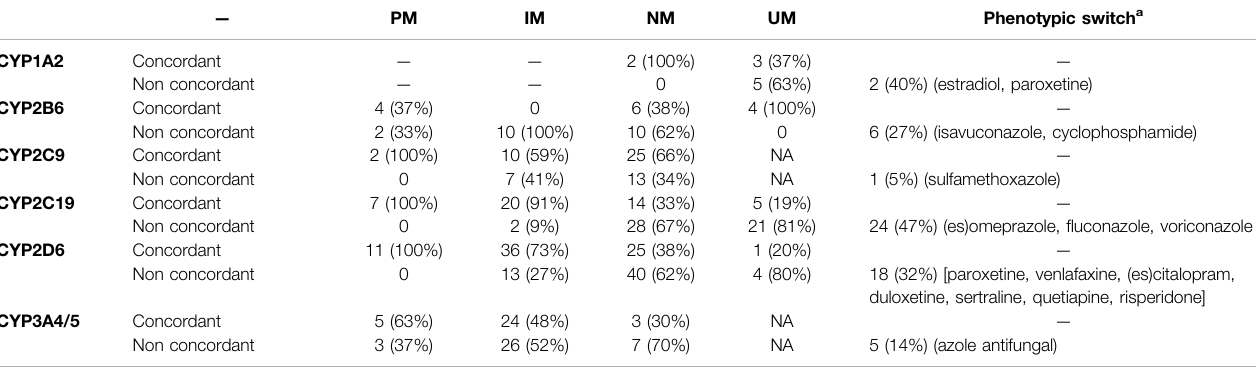
TABLE 3 | Concordance between the predicted and measured and phenotypes, given as n (%).